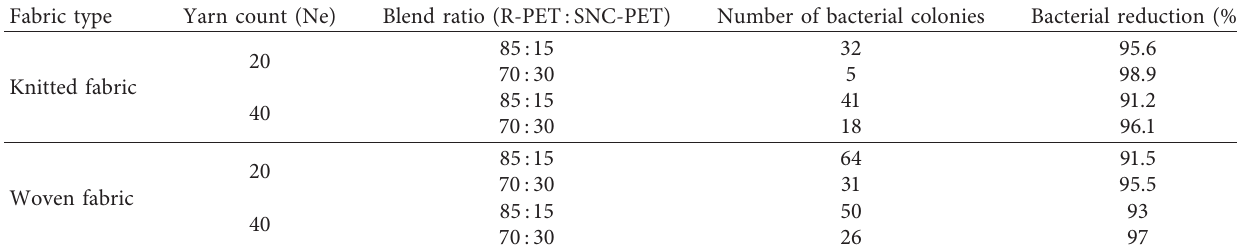
Table 10: Antibacterial activity results for S. aureus